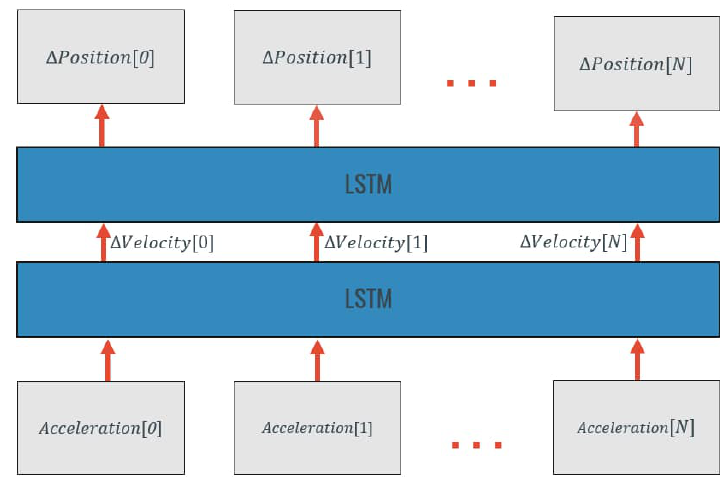
Figure 3. “Smart” double integration by a two-Layer LSTM (Acceleration[i], linear acceleration at instant i; ∆ Velocity[i], velocity change at instant i; ∆ Position, displacement at instant i; LSTM, Long-Short-Term Memory Network Layer).